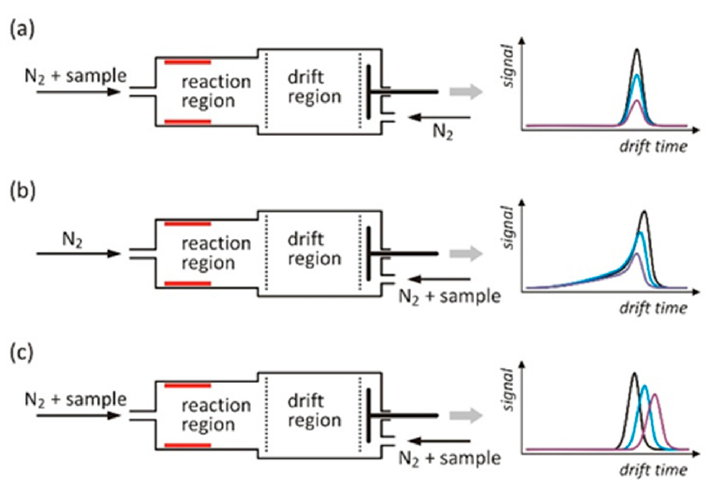
Figure 1. Different variants of the sample introduction method into the IMS detector: ( a ) Measure- ments of drift times and ion mobilities; ( b ) measurement of the electron attachment rate; ( c ) peak shift studies from which the equilibrium constant for the clustering reaction was determined. The drift time spectra shown on the right correspond to the different concentrations of the sample introduced into the carrier or drift gas.